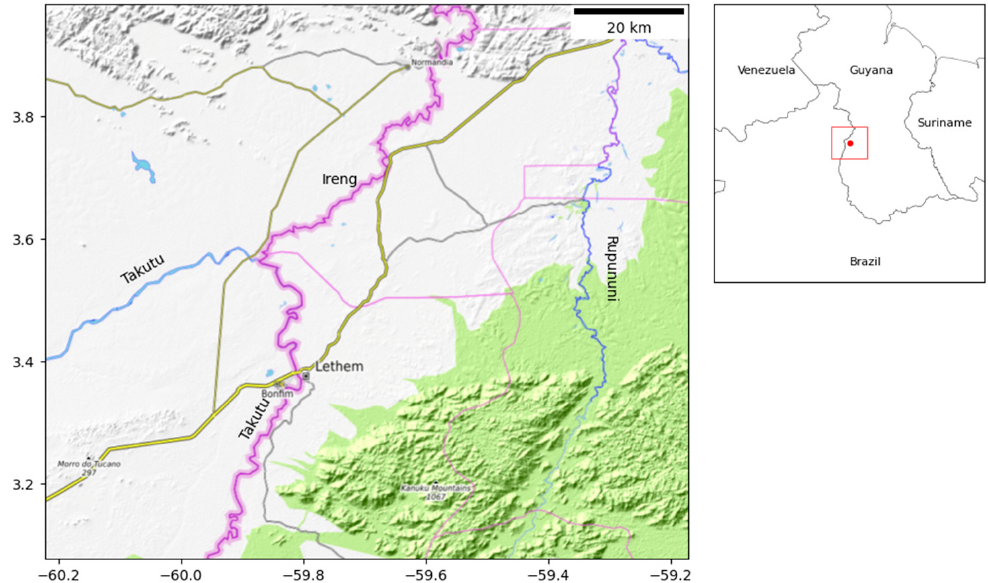
Figure 2. Open TopoMap showing the North Rupununi Study Area within Guyana (highlighted with red square and point) with the Takutu, Ireng and Rupununi Rivers labelled. Areas of Wetland are not currently depicted on Open TopoMap data.